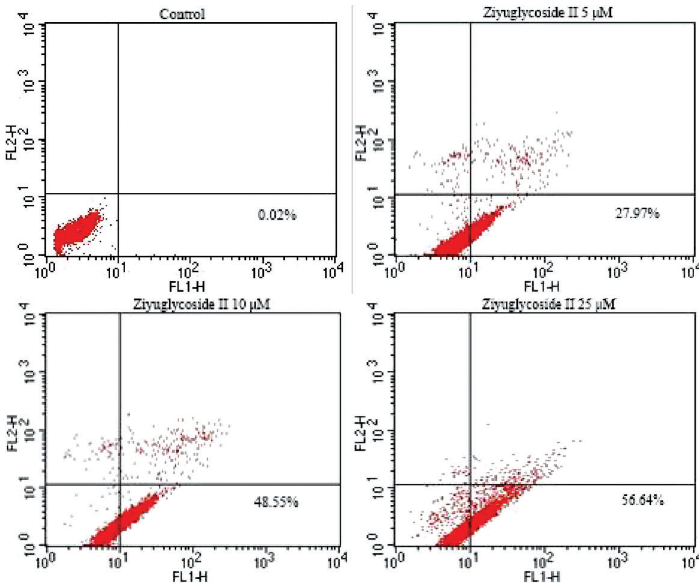
Figure 3. Effects of ziyuglycoside II on cell apoptosis in BGC-823 cells after a 24-h treat- ment. Cells were fixed and stained with Annexin V-FITC and propidium iodide (PI) and then assessed by flow cytometry. Annexin V + PI - data are reported as percents of apoptotic